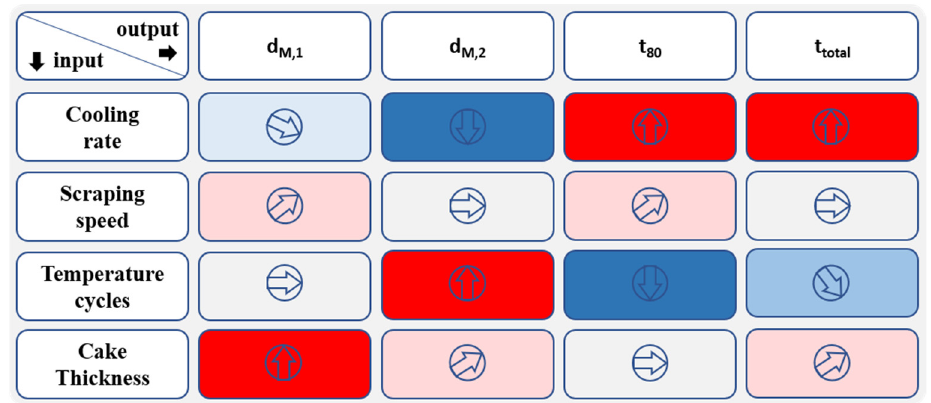
Figure 8. Overview of how the applied parameters influence the crystal size (d M,1 and d M,2 ), primary drying time (t 80 ) and the total drying time (t total ). Red shows an increasing effect and blue shows a decreasing effect if the input parameter is increased. A lighter color stands for lower impact.